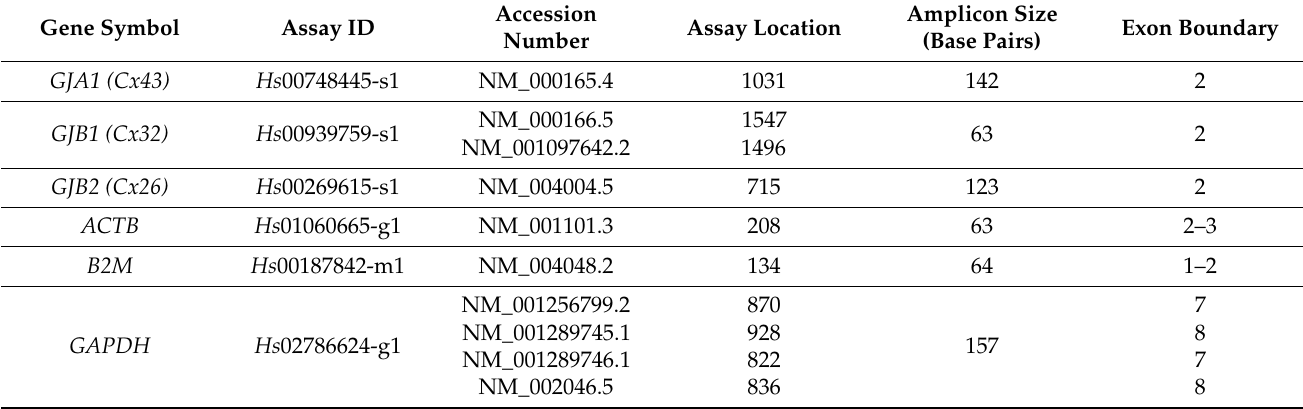
Table 2. Primers and probes for real-time quantitative reverse transcription polymerase chain reaction (RT-qPCR) analysis. Assay identification (ID), accession number, assay location, amplicon size and exon boundaries are listed ( GJA1 , Cx43; GJB1 , Cx32; GJB2 , Cx26; ACTB , actin beta; B2M , beta-2-microglobulin; GAPDH , glyceraldehyde-3-phosphate dehydrogenase; HMBS , hydroxymethylbilane synthase; UBC , ubiquitin